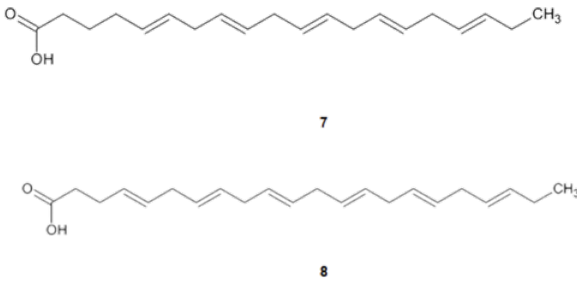
Figure 2. Polyunsaturated Fatty Acids from macroalgae.